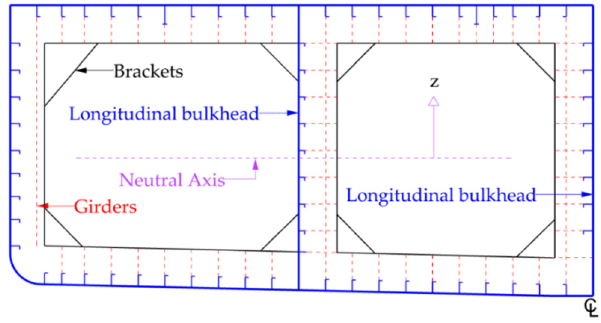
Figure 2. Transversal view of the half of barge midship